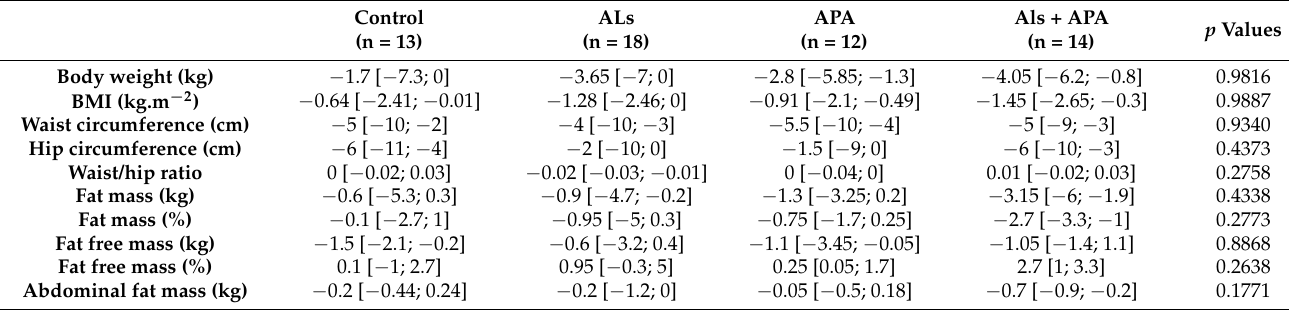
Table 2. Demographic changes observed after 6 months of treatment: delta m0–m6.